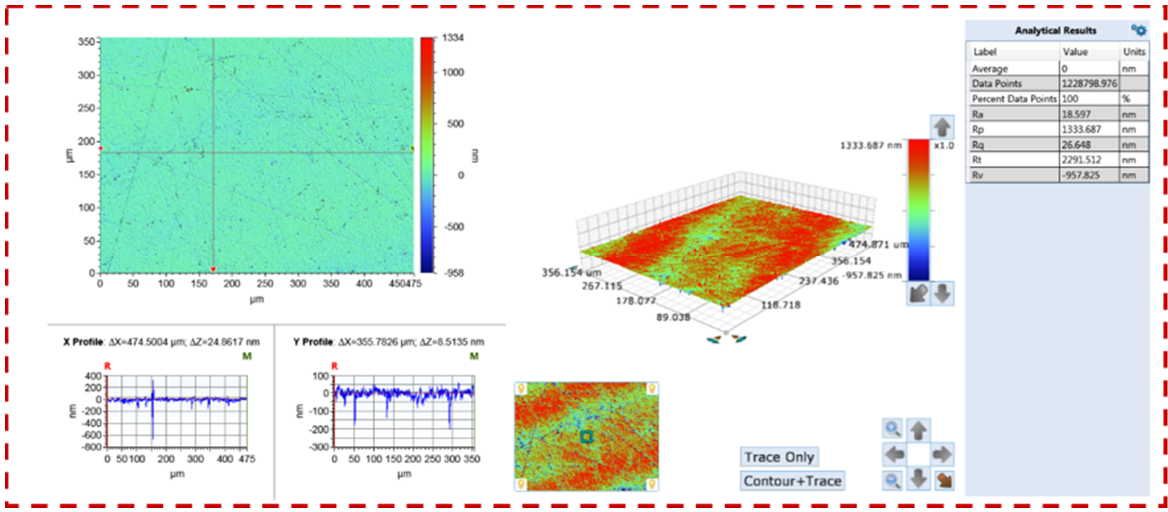
Figure 19. 2D and 3D morphologies and surface roughness of the C-plane surfaces after being polished by the consolidated abrasive particles.